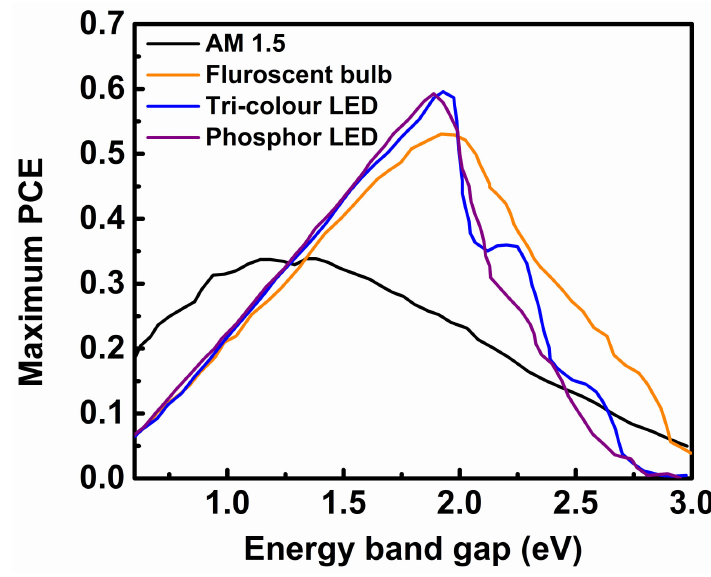
Figure 3. Variation of the estimated maximum PCE with the bandgap energy values of various materials for di ff erent illuminating agents. (Reproduced from [46], with permission from Wiley,